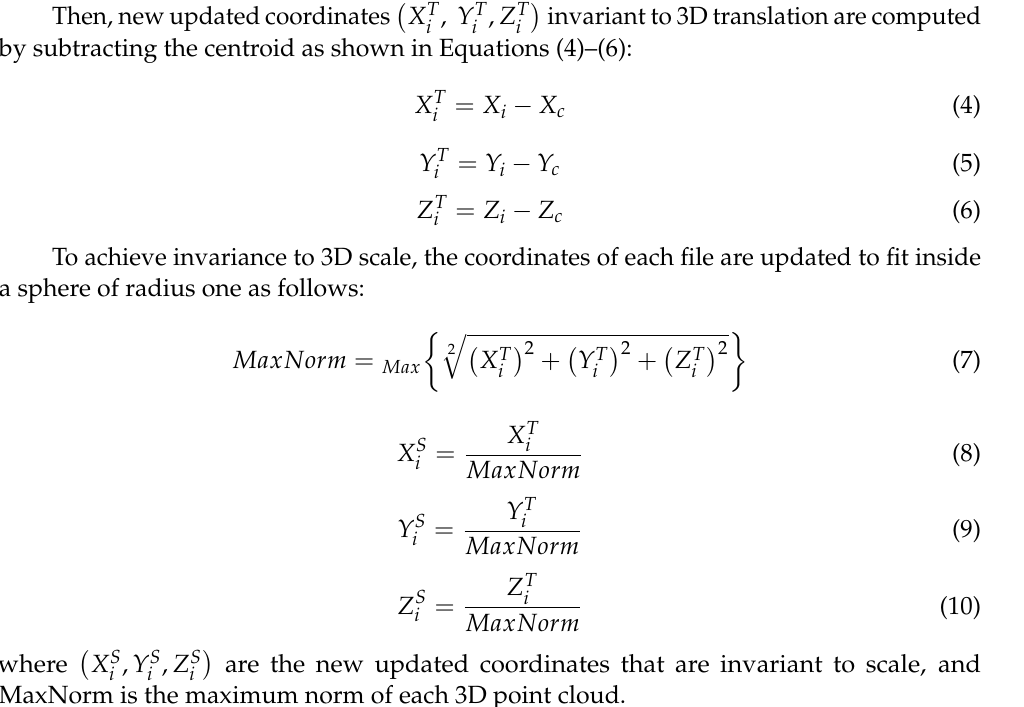
Figure 3. Main steps in the learning ( a ) and recognition process ( b ) of static letters from the Mexican Sign Language alphabet, using features derived from the partition of a unit sphere and a cube containing a normalized 3D point cloud.